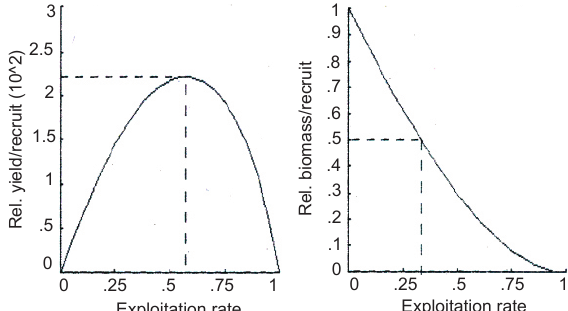
Figure 7. Relative yield per recruit and biomass per recruit of Horabagrus brachysoma from Periyar River ( L / L = 0.260 and M / K = 1.89) c α